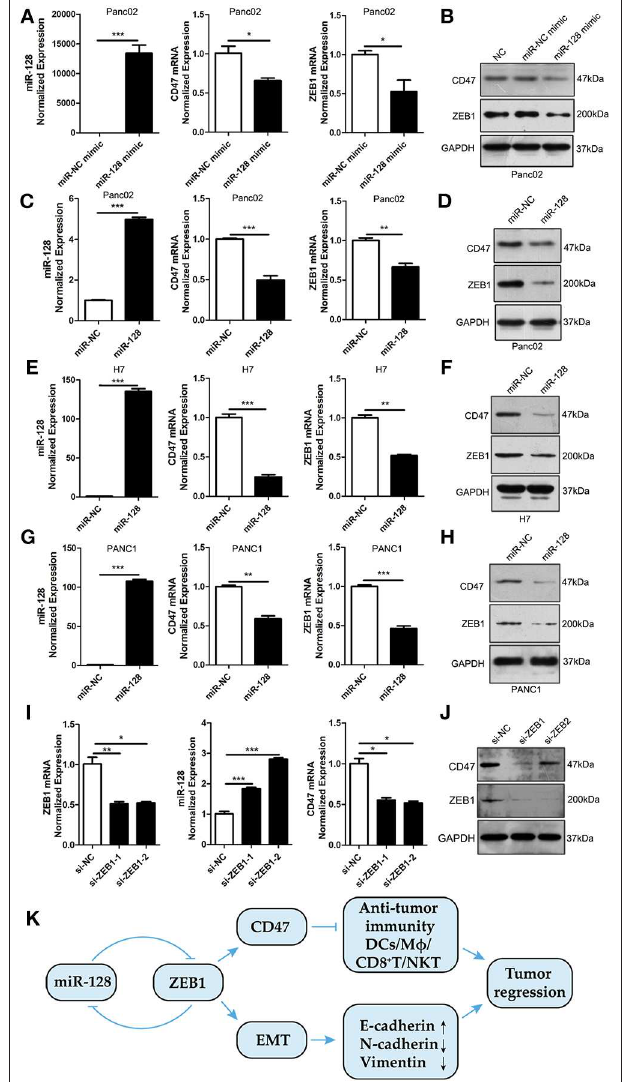
FIGURE 6 | miR-128 promotes anti-tumor immunity through the ZEB1/CD47 axis. (A,B) The expression of CD47 and ZEB1 were downregulated in miR-128 mimic-transfected Panc02 cells. (C,D) The expression of CD47 and ZEB1 were downregulated in miR-128 lentivirus-infected Panc02 cells. (E,F) The expression of CD47 and ZEB1 were downregulated in miR-128 mimic-transfected H7 cells. (G,H) The expression of CD47 and ZEB1 were downregulated in miR-128 mimic-transfected PANC1 cells. (I,J) The expression of ZEB1, miR-128, and CD47 in ZEB1 knockdown Panc02 cells. (K) A schematic of the molecular mechanism by which miR-128 causes tumor regression. These results represent the mean ± SEM from three independent experiments. Comparisons between groups were determined by Student’s t -test. * p < 0.05, ** p < 0.01, and *** p <